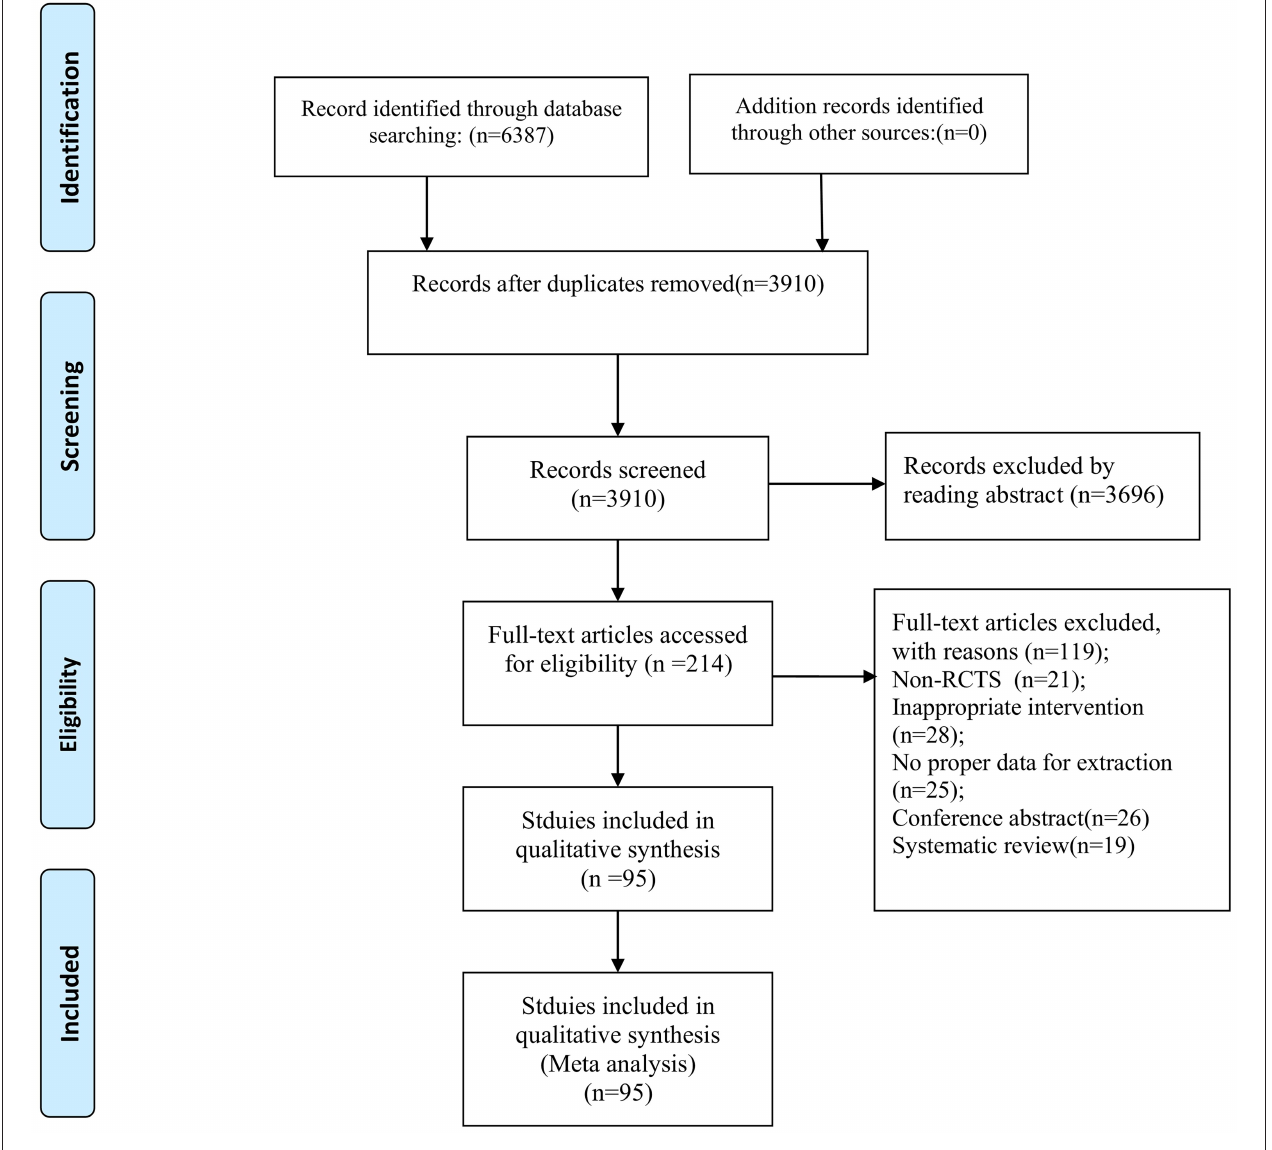
FIGURE 1 | Flowchart of the study selection